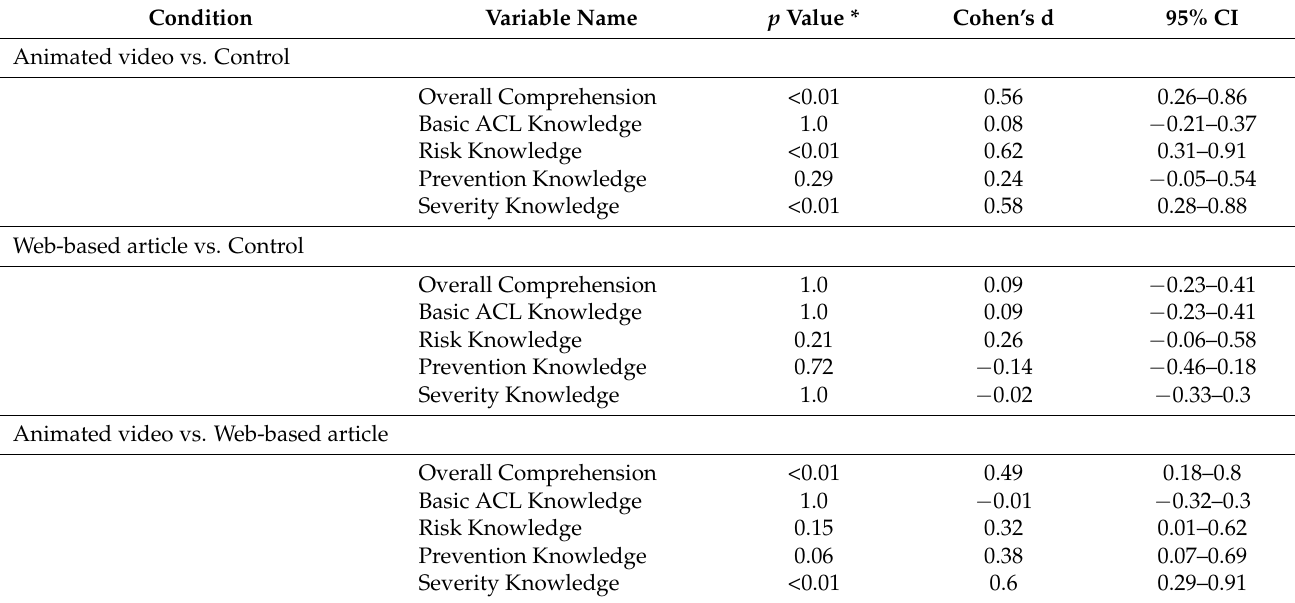
Table 4. Comparisons between conditions at time